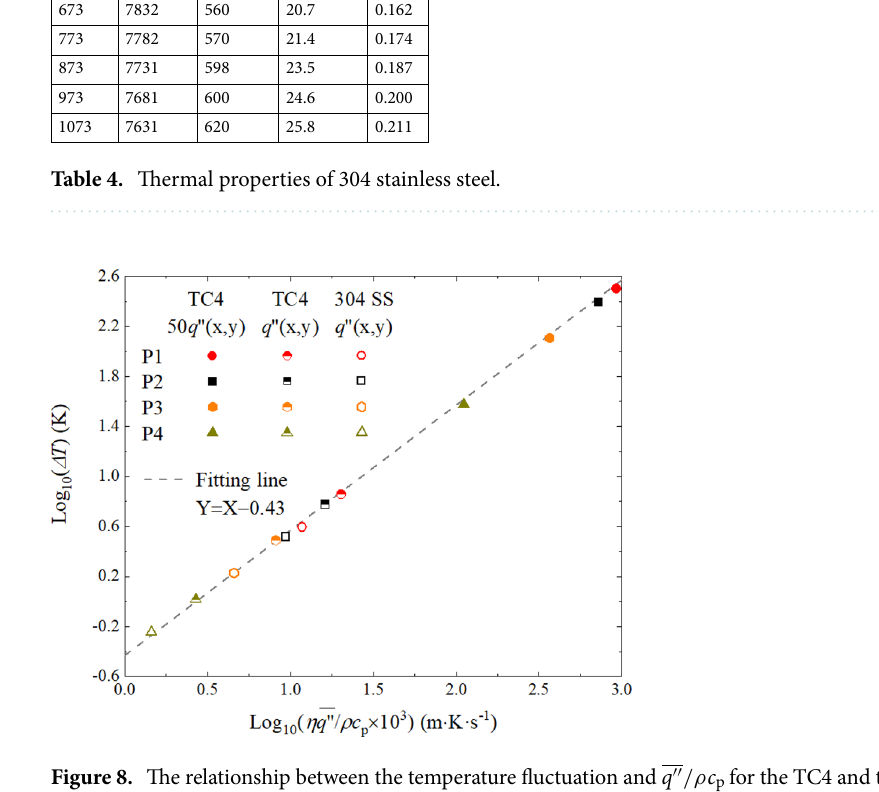
Figure 8. The relationship between the temperature fluctuation and q ′′ /ρ c p for the TC4 and the 304 stainless steel (304 SS)